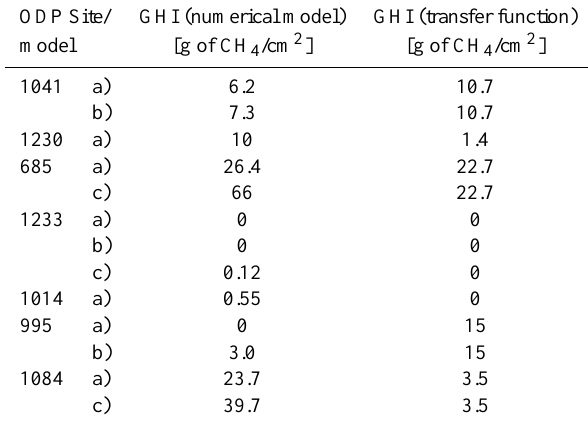
Table 3. Comparison of the GH amounts of the ODP sites calcu- lated in the different model runs: a) constant POC input, b) varying POC input, c) time-dependent POC input and advective fluid flow, with the transfer function, using the input data of the ODP mod- els. In order to use the transfer function (Eq. 6) the data of the a-models included in Table 1 were used to calculate POCar. The GHSZ was deduced from BSR depths given in the respective ODP initial reports, or calculated by the respective thermal- and pressure